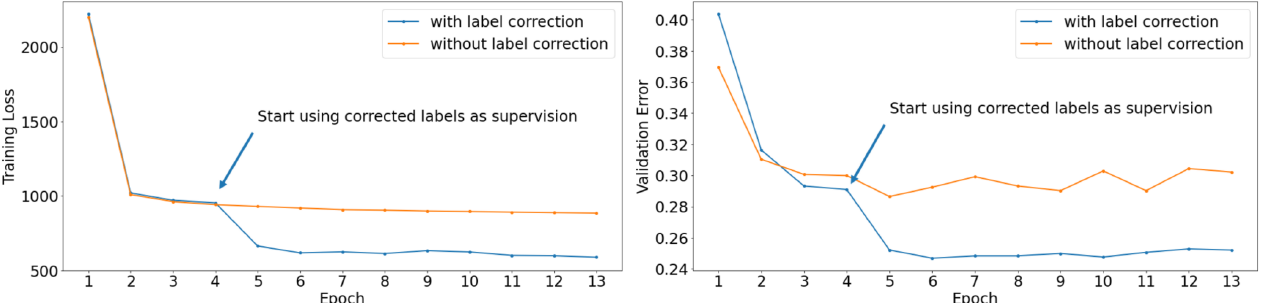
Figure 3. Training loss ( left ) and validation error ( right ) when training with and without co-corrected labels on the PalmTrees dataset. Best viewed in